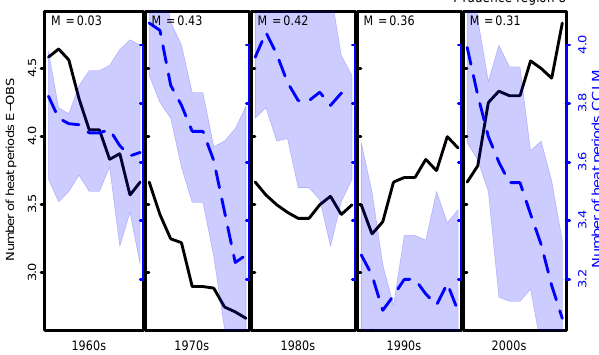
Figure 5. Number of heat periods (1961–2010) in Eastern Europe (Prudence 8) in summer from E-OBS o (black) and CCLM num- ber of heat periods (blue: ensemble mean and interquartile range). The M’s denote the absolute mean difference within a decade be- tween E-OBS and the CCLM ensemble mean after normalization (see Eq. 6).